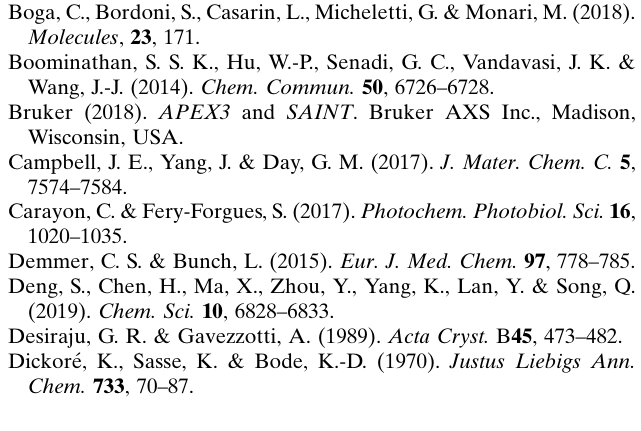
), with U (H) = 1.2 U 3 iso